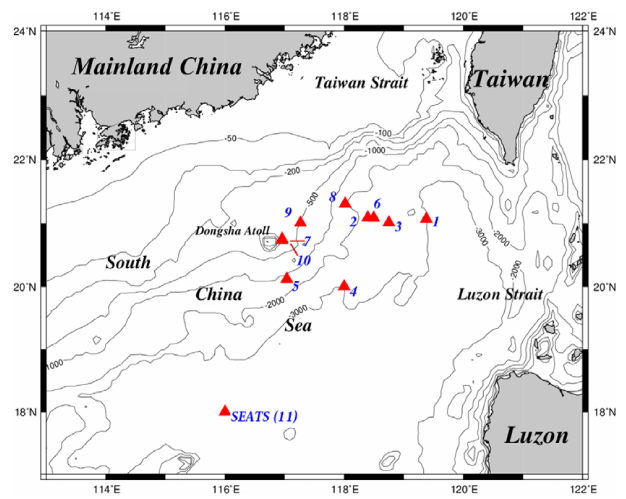
Figure 1. Maps of the study area and sampling stations. The sam- pling stations were located mainly in deep-water regions, except for the shallow stations (stations 7 and 10) close to the Dongsha Atoll. All stations were renamed numerically to avoid confusion with the names originally used in different cruises. For seasonal and spatial comparison, the sampling stations were grouped into two domains, one located in the upper NSCS and one located in the central basin represented by the SEATS (11) station. SEATS denotes the South- east Asian Time-series Study station in